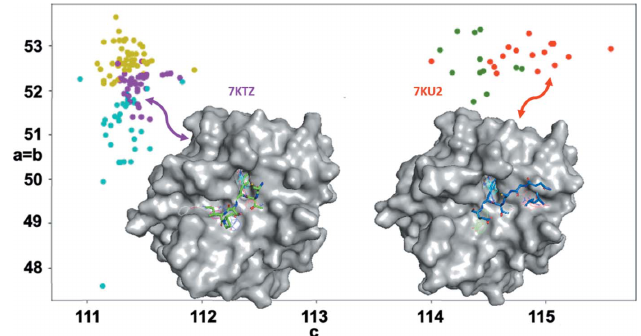
Figure 8 Diffraction data from 146 ChTg crystals. Each data set is shown as a dot according to its unit cell values ( x and y coordinates) and according to its grouping after to two-factor clustering (five colors). The data readily partition into two main groups using conventional one-factor clustering (two main populations at left and right), and further subdivide into five sub-groups using two-factor clustering. FTMap was used to compare the predicted binding properties of the different structural polymorphs, which differed markedly between the two main cluster groups (the inset shows binding poses superposed on the protein envelopes of 7ktz and